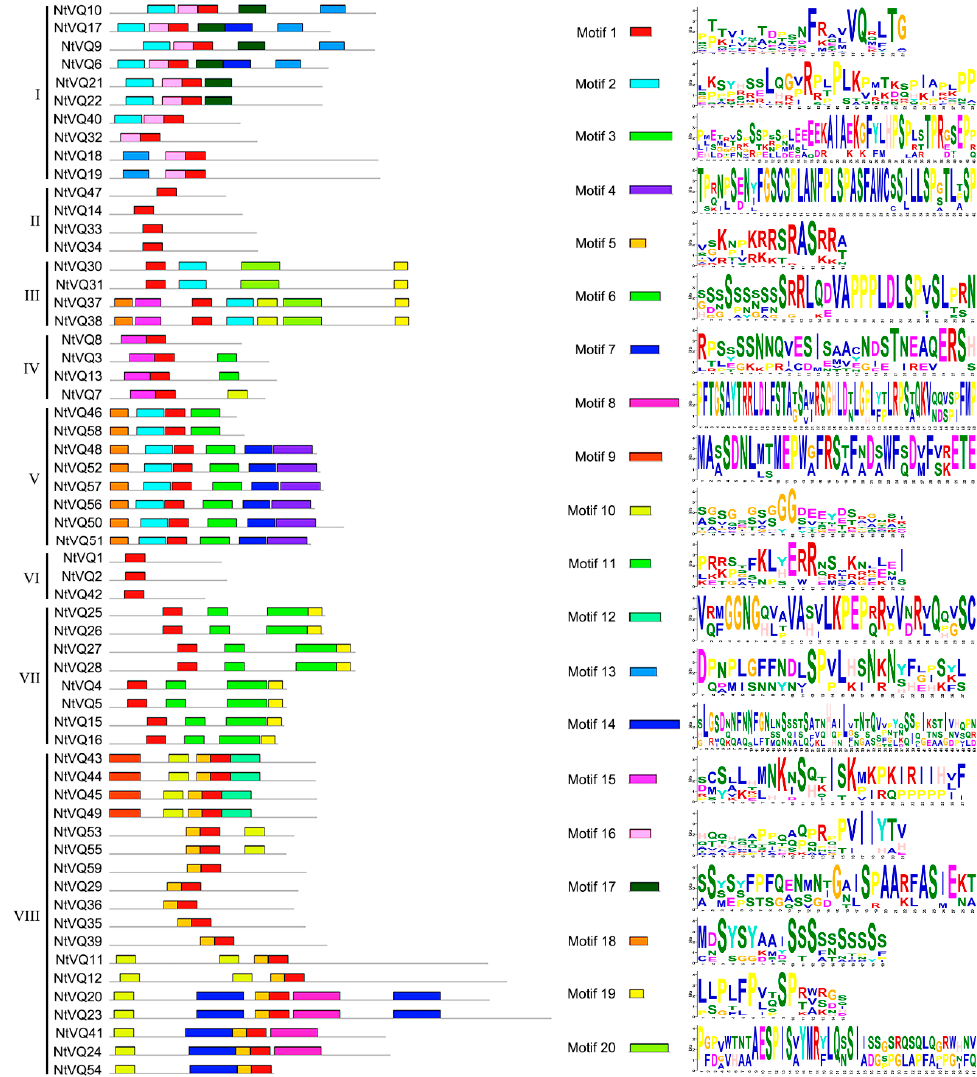
Figure 3. Motif composition of whole amino acid sequences in NtVQ proteins determined by MEME. Twenty motifs were identified from the complete amino acid sequences of 59 NtVQ proteins. Combinations of different motifs in each NtVQ are indicated on the left and detailed information on each motif is shown on the right.